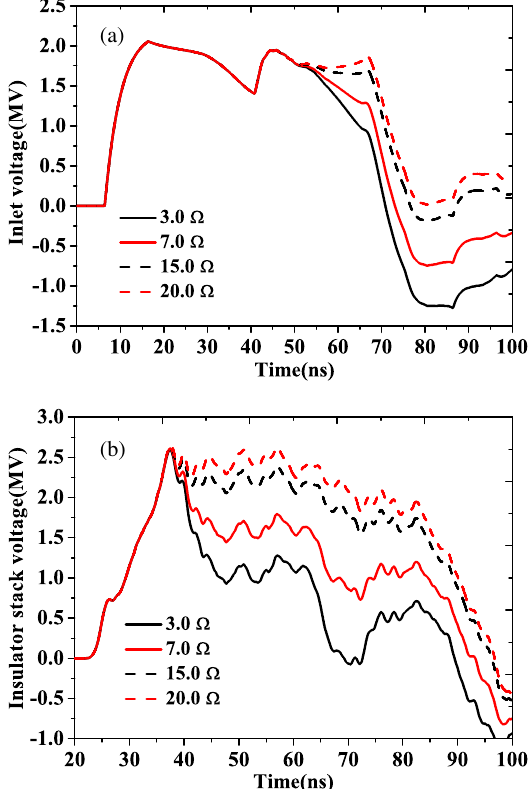
FIG. 13. (a) Oil elbow inlet and (b) insulator stack voltage waveforms with different load impedance acquired by 2D circuit simulation. The insulator stack voltage probe is at 0